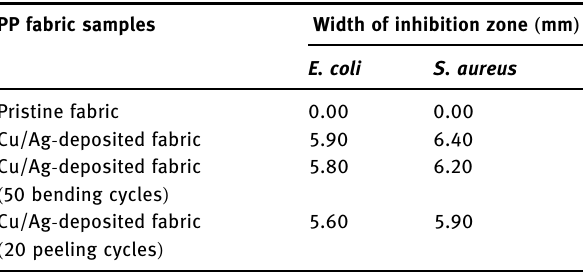
Table 2: Antibacterial results of PP fabric samples under di ff erent conditions PP fabric